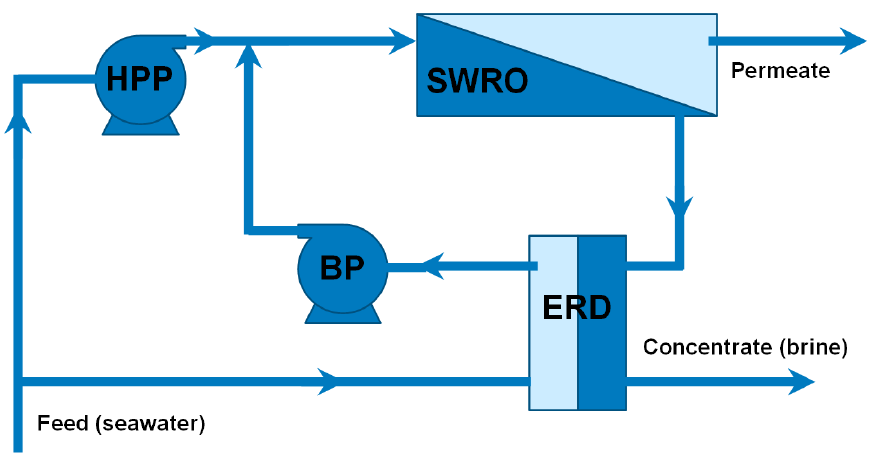
Figure 3. RO system configuration scheme.